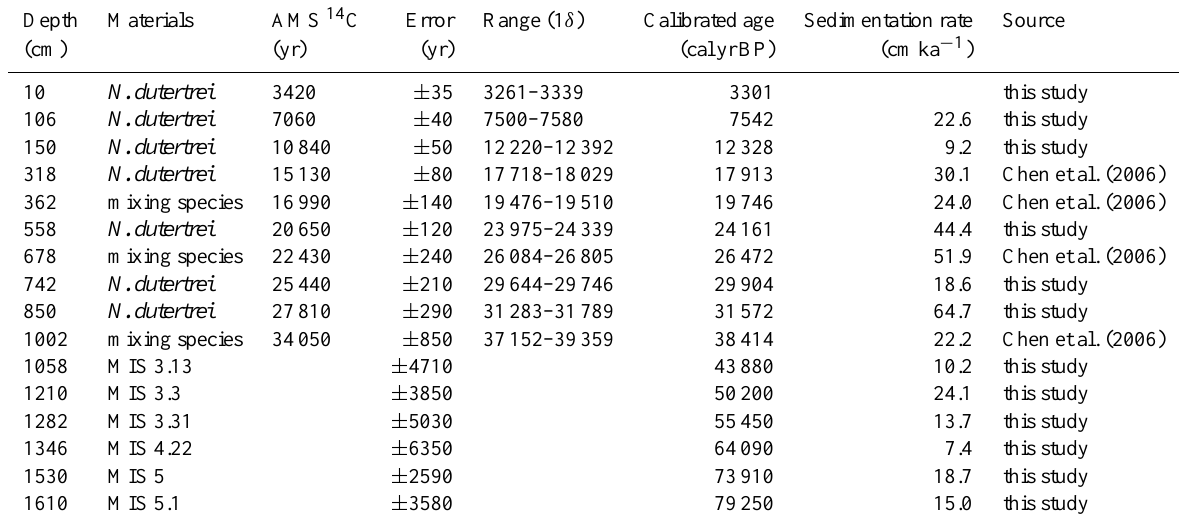
Table 1. Details of age controlling points of accelerator mass spectrometry radiocarbon (AMS 14 C) and δ 18 O of planktonic foraminifera in core CSH1 used for age model